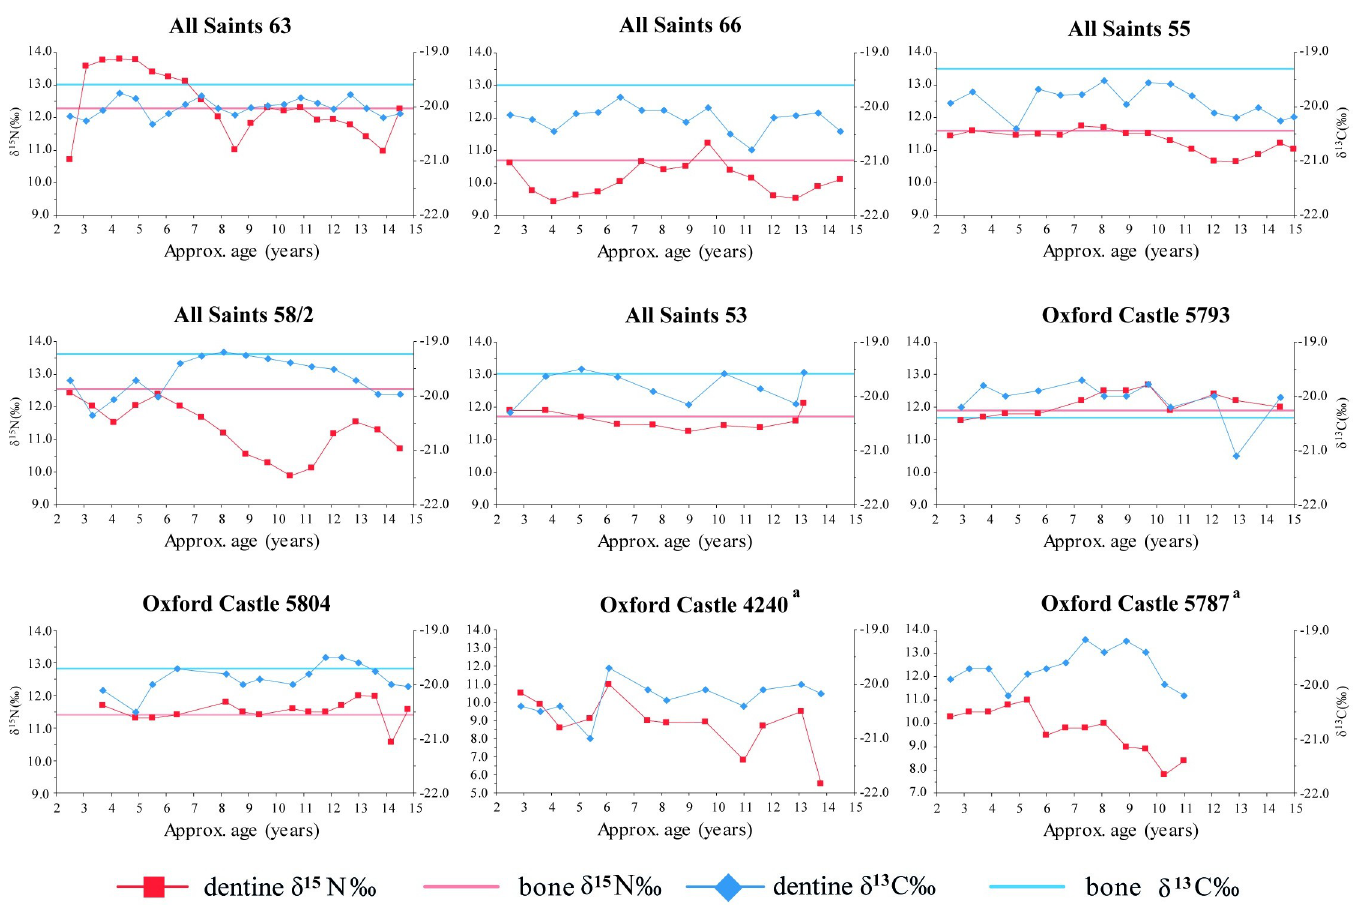
Fig 7. Incremental dentine δ 15 N and δ 13 C value profiles for individuals from All Saints (AST) and Oxford Castle (OXC).